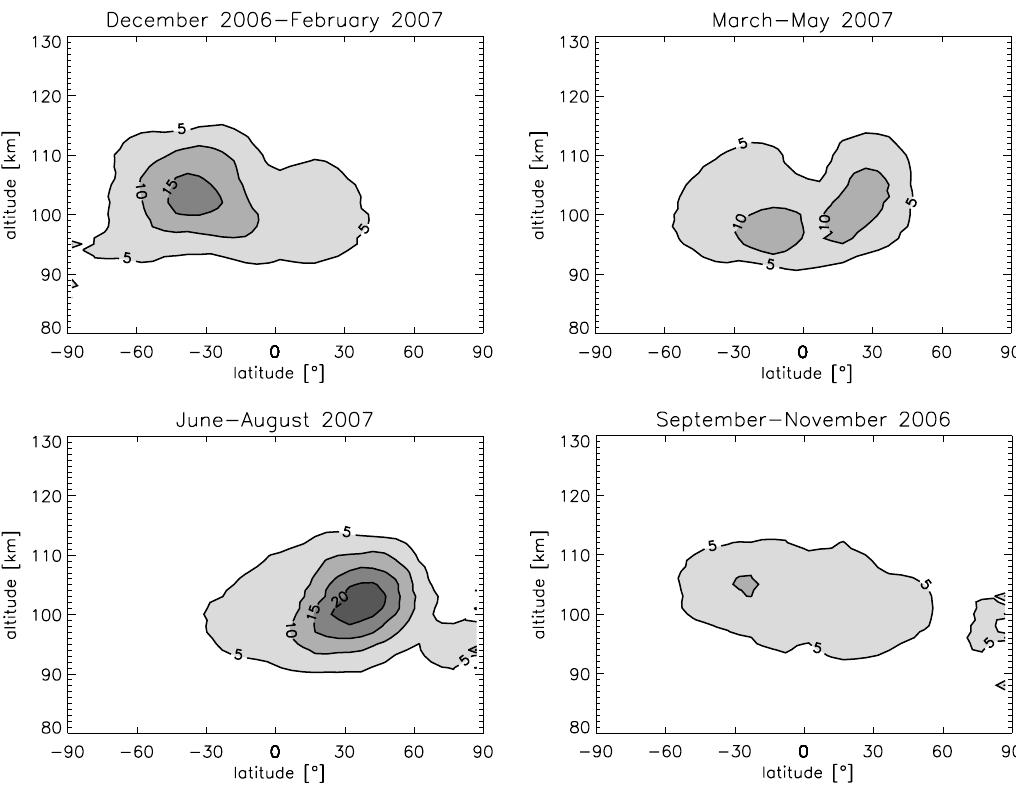
Fig. 1. Combination of CHAMP, GRACE and FORMOSAT-3/COSMIC RO mean relative E s occurrence rate for 4 seasons (3-monthly means). Values are given in 1/1000.